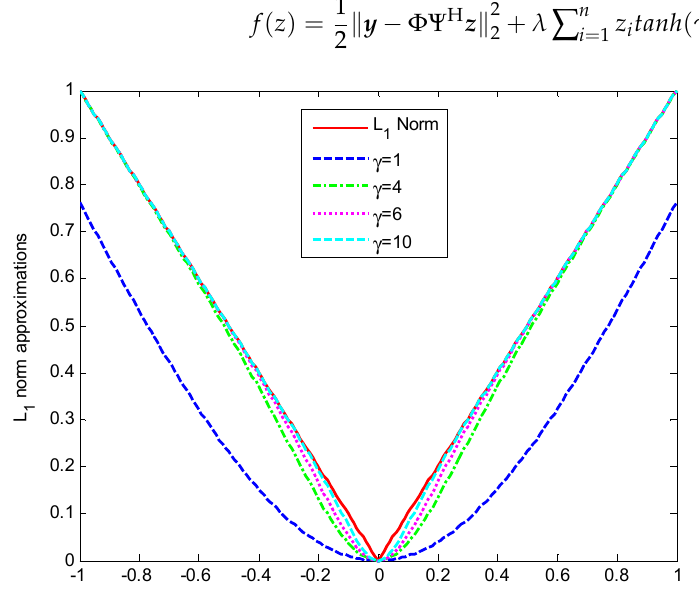
Figure 1. l 1 norm approximation using the hyperbolic tangent function for different values of γ = (1, 4, 6, and 10). As the value of gamma continues to increase and the approximation is closer to the actual l 1 norm, however, it is less smooth. The proposed technique gives us the flexibility to choose between the level of smoothness and accuracy .